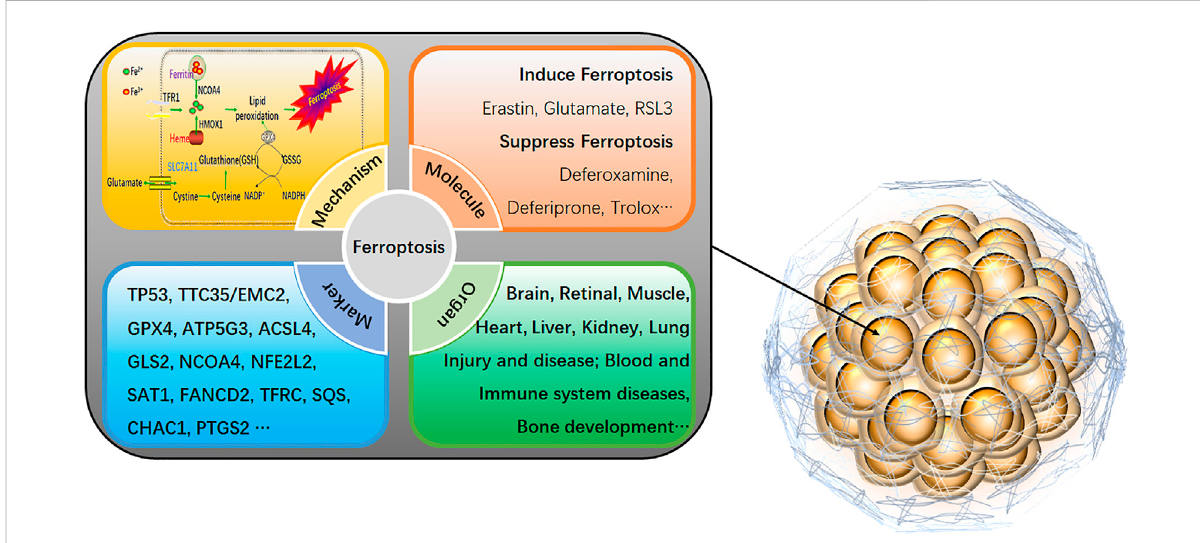
FIGURE 1 An overview of ferroptosis in 3D cells. The speci fi c mechanism of ferroptosis is as follows: 1) GPX4 inactivation leads to GSH consumption. In cells,GPX4canconverttheperoxybondoflipidperoxidationintoahydroxyl groupandloseitsperoxideactivity.Itistheonlyglutathione peroxidase used for liposome peroxide reduction. Based on the enzymatic activity of GPX4, its main targets are System Xc-system (responsible for transporting cysteine, a synthetic raw material of GSH into the cell), glutamate-cysteine ligase, glutathione s-transfer enzymes, etc. 2) Direct inactivation of GPX4. In addition to indirectly acting on GSH that activates GPX4, GPX4 inhibitors, squalene synthase, etc., can also directly eliminate GPX4. 3) Iron ion input and iron ion reduction. Input iron ions into cells and ensure that iron ions exist in large quantities in the form of divalent iron ions (Fe 2+ ), which can initiate liposome peroxidation through the Fenton reaction. As a new cell death mechanism, ferroptosis has recently been a research hotspot.Itcanbeinvolvedincancercelldeath,neurotoxicity,neurodegenerativediseases,acuterenalfailure,drug-inducedhepatotoxicity,liverand cardiac ischemia/reperfusion injury, T cell immunity, and other life processes (Neurodegeneration, Multi-organ dysfunction, Retinal pigment epithelial cell degeneration, Asthma, Defective kidney repair, Sickle cell disease, etc.). Activating or inhibiting ferroptosis can interfere with the development of diseases. Therefore, it is of great practical signi fi cance for the clinical treatment of human diseases to explore the role of ferroptosis in various conditions by sorting out the related genes that affect